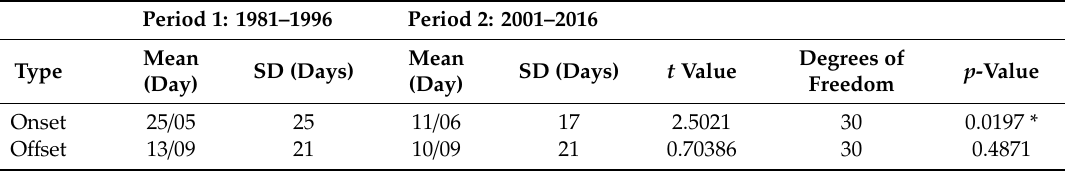
Table 3. Onset / o ff set days analysis statistics of the two examined periods for Khulna station. SD = standard deviation. Asterisk (*) indicates significance at 95% confidence